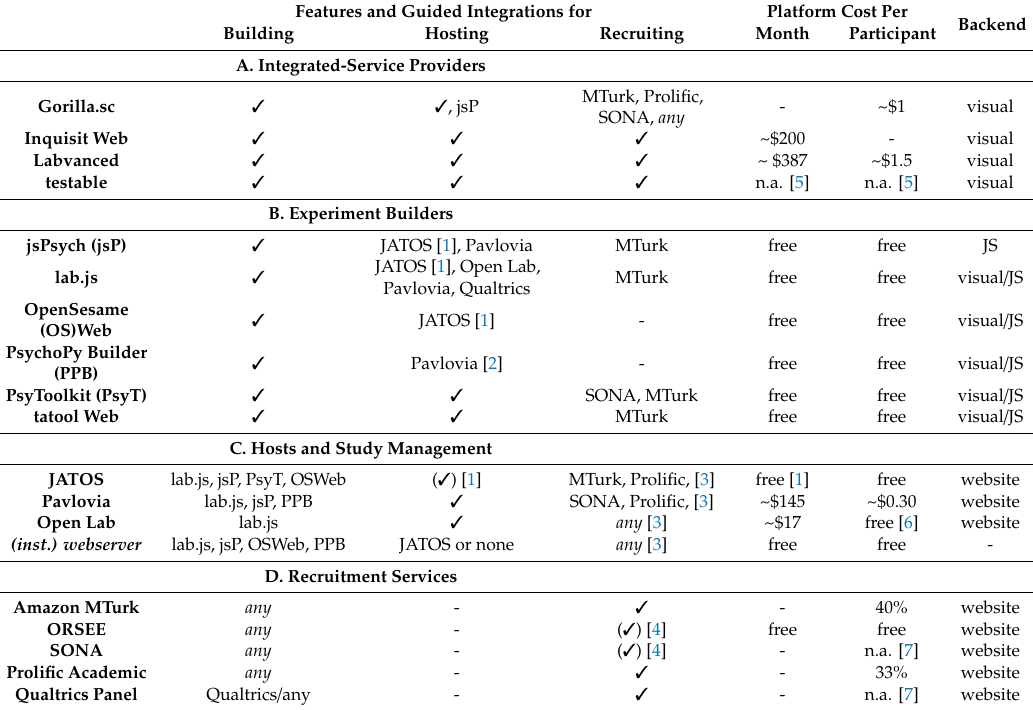
Table 1. Simplified comparison of actively maintained tools for online studies in respect to their features, guided integrations (i.e., documentation on website), backends and costs. Features and Guided Integrations for Platform Cost Per